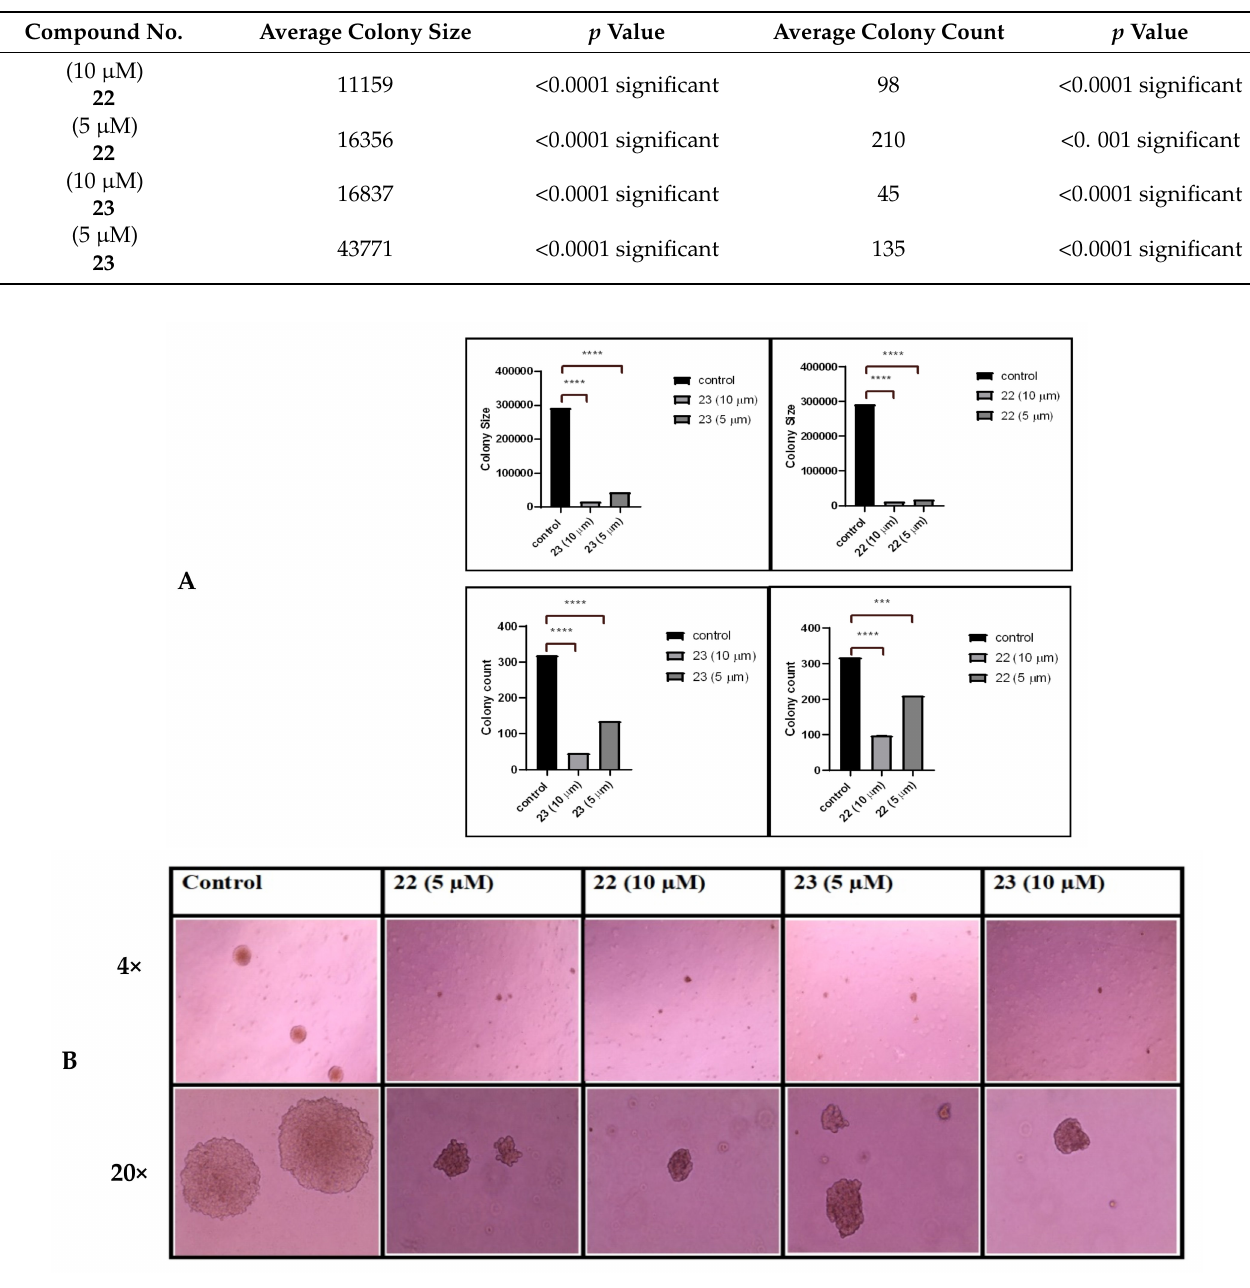
Figure 3. ( A ) Effect of treatment on A549 cells colony size and count in column representation. ( B ) Pictures of the colonies were captured by 5.0 Mega Cmos camera at 4 × and 20 × magnification The colony-forming assay was performed by seeding equal amount (1 × 10 4 ) of cells treated with IC 50 and sub-IC 50 concentrations of compounds 22 and 23 in soft agar in 6-well tissue culture plates. Cells were photographed after 12